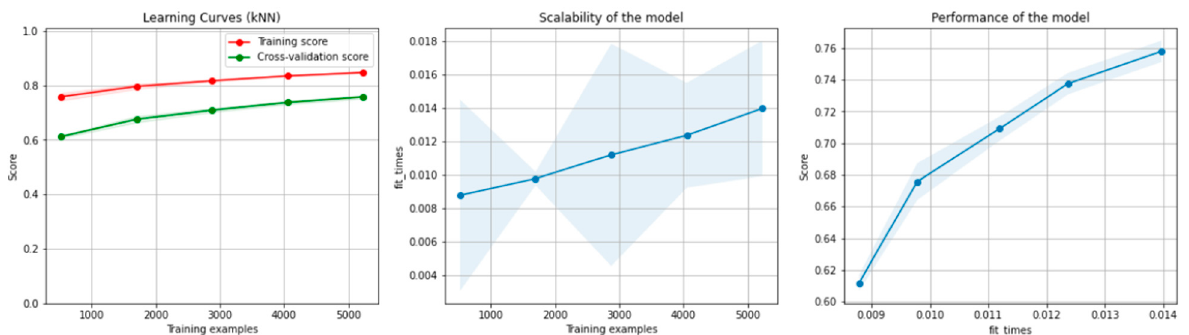
Sensors 2021 , 21 , x FOR PEER REVIEW